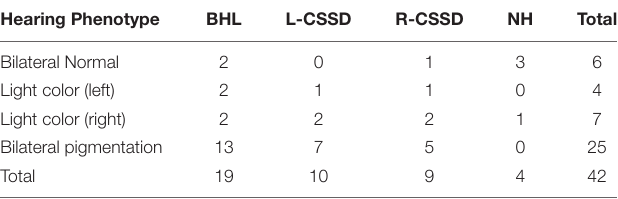
TABLE 1 | The Iris color and the hearing loss in 5 th Generation.